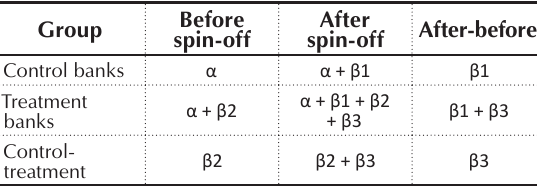
Table (cid:1006). (cid:24)(cid:349)(cid:299)(cid:286)(cid:396)(cid:286)(cid:374)(cid:272)(cid:286)(cid:882)(cid:349)(cid:374)(cid:882)(cid:282)(cid:349)(cid:299)(cid:286)(cid:396)(cid:286)(cid:374)(cid:272)(cid:286)(cid:400)(cid:3)(cid:296)(cid:396)(cid:258)(cid:373)(cid:286)(cid:449)(cid:381)(cid:396)(cid:364) Group Before spin-off After spin-off After-before